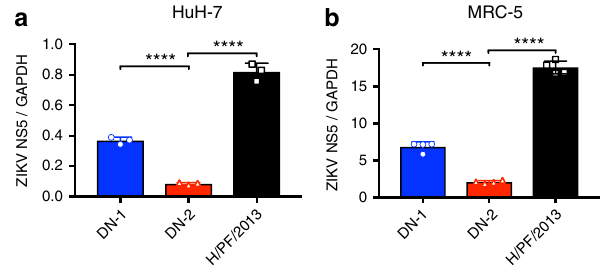
Fig. 6 Intracellular viral replication determined by qPCR after 20 and 24h post infection in a HuH-7 cell line ( n = 3) and b MRC-5 cell strain ( n = 4). Error bars represent s.d. **** p < 0.0001 in unpaired t doses of inoculum. Viremia levels remained detectable at death in animals infected with H/PF/2013 (Fig. 7c, d). Peak DN-1 viremia was similar to H/PF/2013 at 10 4 p.f.u. of inoculum but 1.5 log 10 lower with 10 3 p.f.u. In contrast, peak DN-2 viremia was the lowest at approximately 10 7 copies per ml at both doses and waned to below detection limit 8 days after inoculation (Fig. 7c, d). These fi ndings demonstrate that the in vivo replication of DN- 2 is attenuated relative to either DN-1 or wild-type ZIKV. The neutralizing antibody titers at day 21 post inoculation trended with the viremia pro fi les of DN-1 and -2, where the lower DN-2 viremia resulted in a 0.5 log 10 lower neutralizing antibody titer than DN-1 infected animals (Fig. 7e). This fi nding is similar to our clinical fi ndings with YF17D vaccination where longer viremia was associated with higher neutralizing antibody titer 16 .